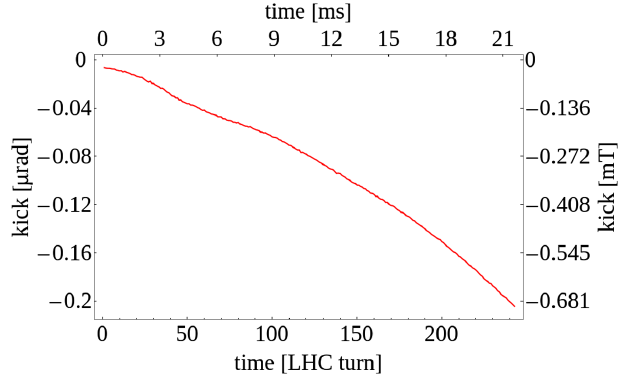
FIG. 23. Kick on the beam during a quench of one of the ATLAS Q1 magnets, calculated from the measured BPM